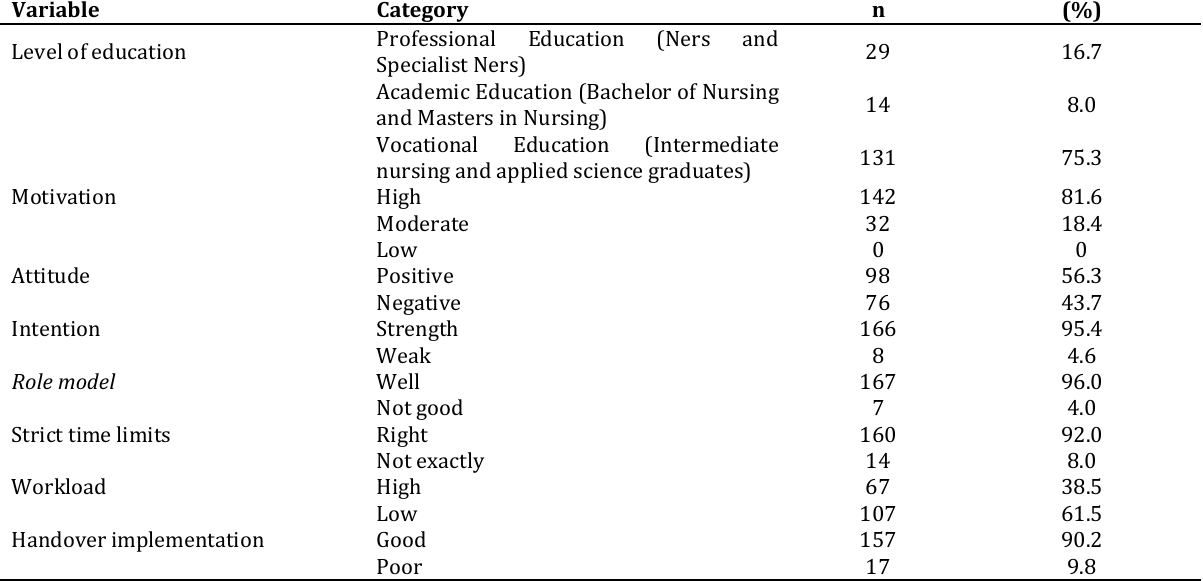
Table 1. Distribution of the respondents according to education level, motivation, attitude, intention, role model, strict time constraints, workload and the handover implementation of nurses in the inpatient ward of Ulin Hospital Banjarmasin; 174 respondents.